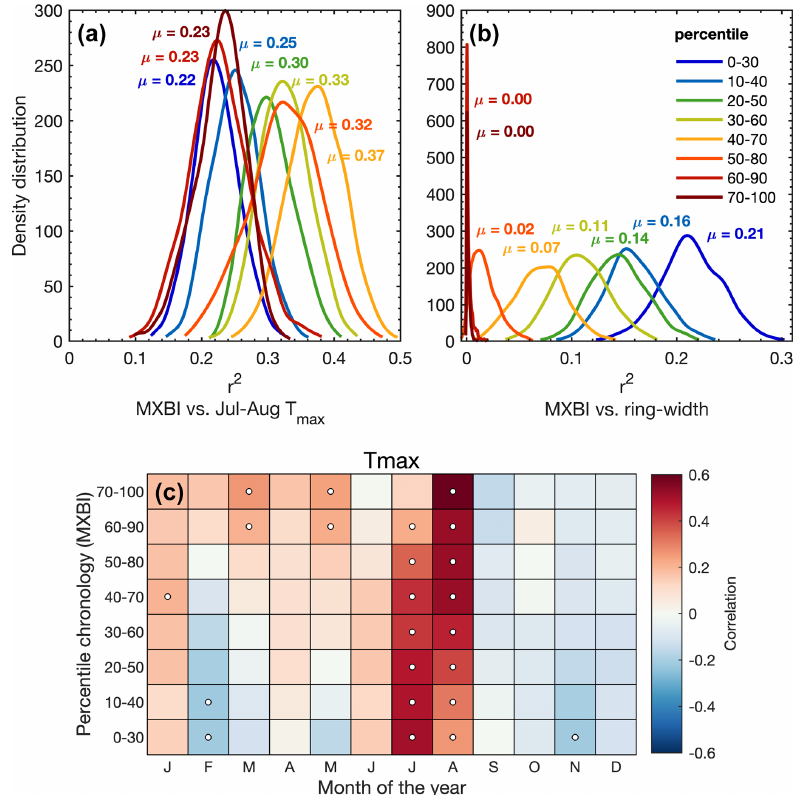
Figure 7. (a, b) The density distribution of r 2 values obtained from 1000 calibration trials (1901–1994 period) where MXBI chronologies are built from 100 series randomly drawn from the total of 182 series without replacement. The detrended MXBI values are sorted into percentiles based on the absolute ring width (e.g., the 0–30 percentile are the corresponding MXBI values for the narrowest 30% of the rings), and then averaged into percentile chronologies. (a) The calibration r 2 values between these chronologies and detrended July–August CRU TS T max , (b) same as (a) but calibrated against the full ( N = 182) detrended ring width chronology. (c) Correlation between the MXBI percentile chronologies and monthly maximum ( T max ) temperatures from the CRU TS v4.03 product (48.25–55.75 ◦ N/113.75–123.25 ◦ W subset average). Correlation coefficients are computed over the 1901–1994 period using detrended tree ring and temperature data. Significant correlations ( p < 0 . 01) are outlined with white